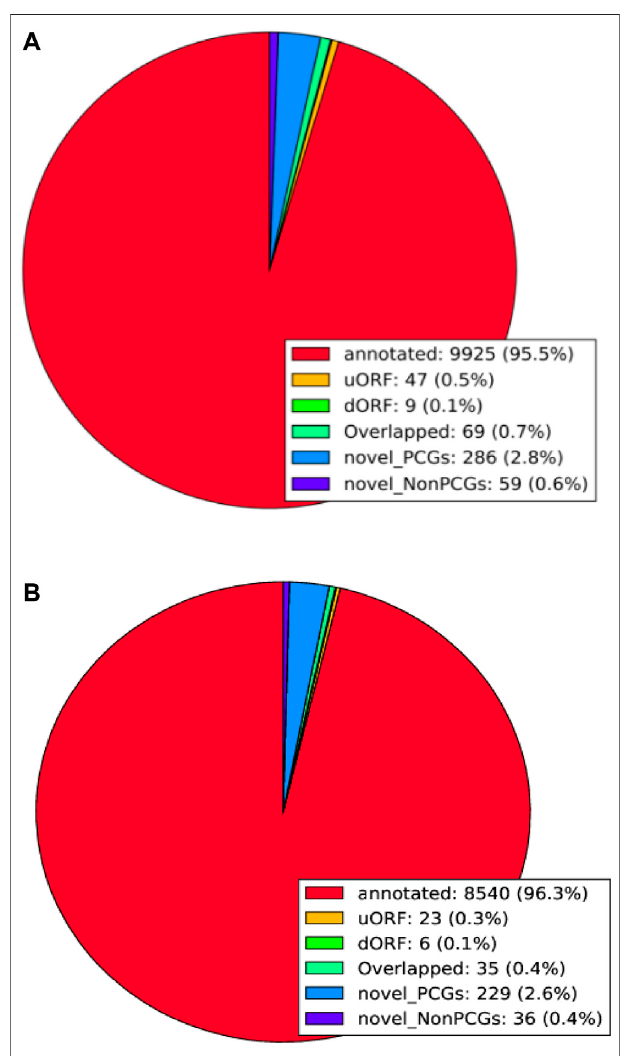
FIGURE7 | ORF analysis ofLCG. (A) ORF analysisof fi ne LCG. (B) ORF analysis of coarse